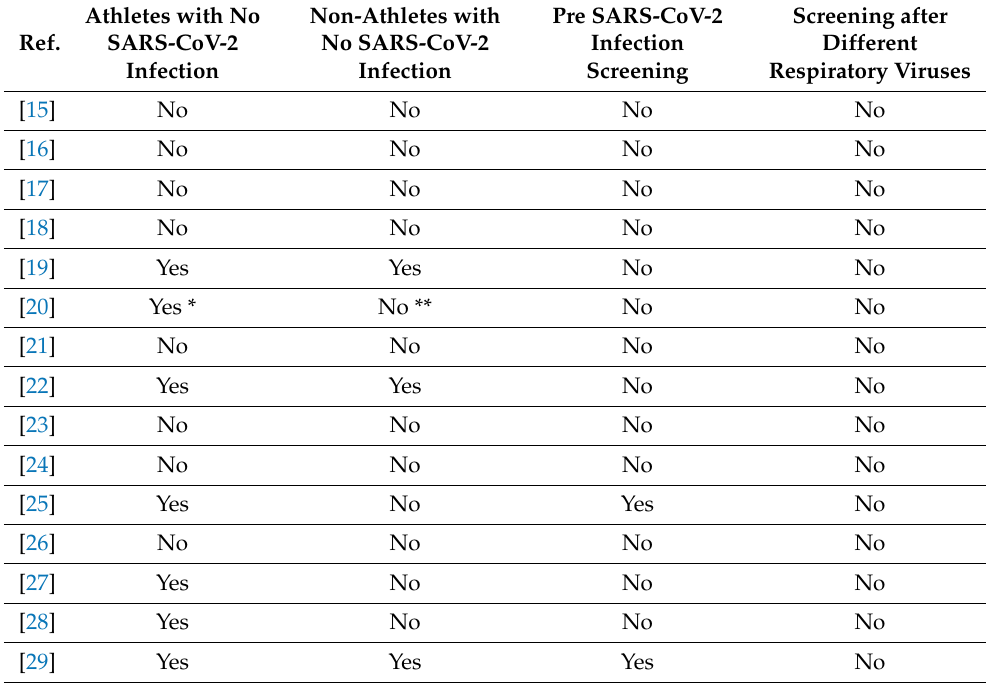
Table 3. Limitation of the studies, assessed by checking the presence of control populations (“Yes” and “No” indicate the presence or absence of a control population, respectively). Screening after Pre SARS-CoV-2 Non-Athletes with Athletes with No Different Infection No SARS-CoV-2 Ref. SARS-CoV-2 Respiratory Viruses Screening Infection Infection No No No No No